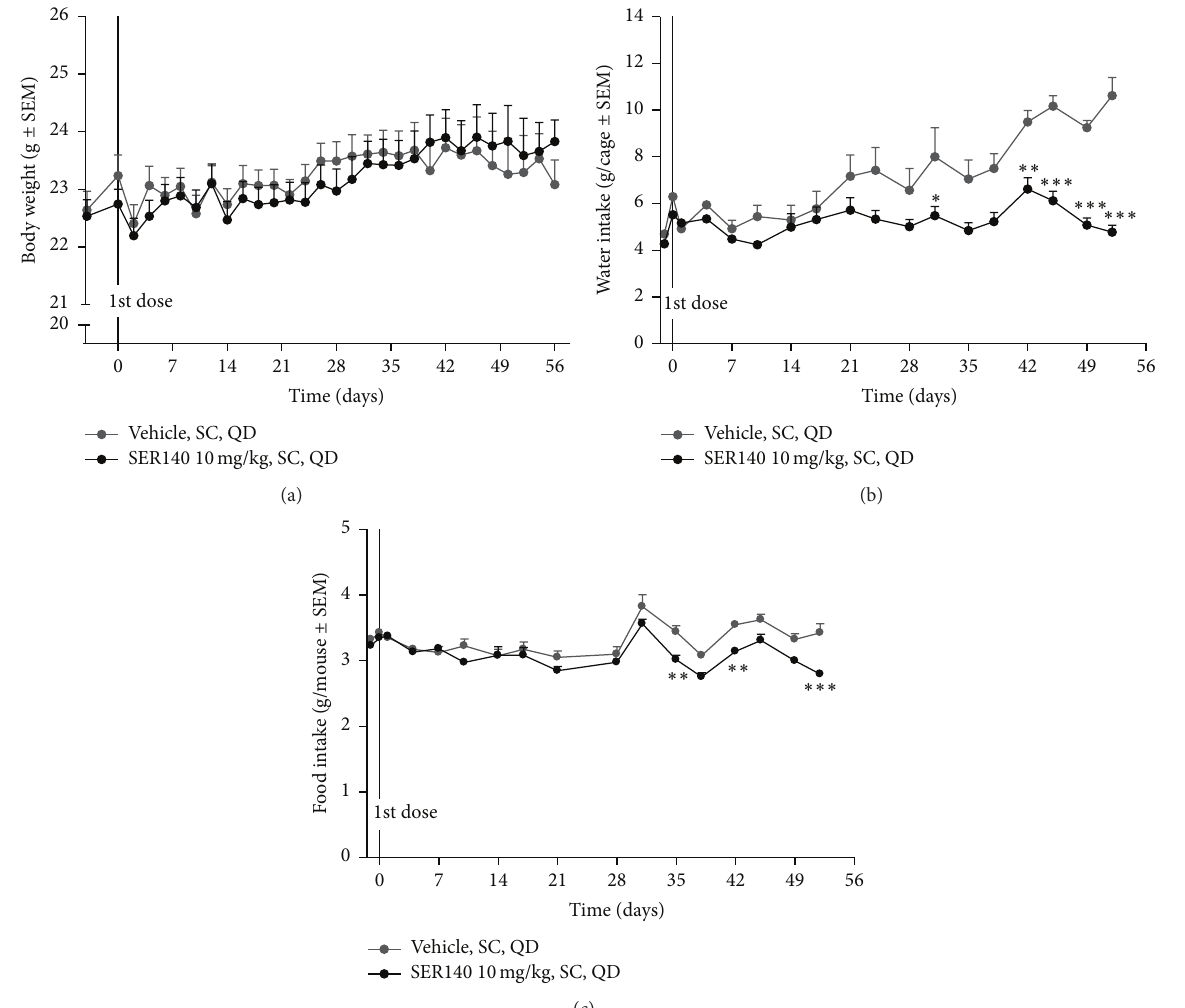
Figure 3: Daily body weight (a), water intake (b), and food intake (c) during the 56-day study period. All data are presented as mean ± SEM ( 𝑛 = 18 –20/group). ((a)–(c)) ∗ 𝑝 < 0.05 , ∗∗ 𝑝 < 0.01 , and ∗∗∗ 𝑝 < 0.001 compared to vehicle; two-way ANOVA w/Bonferroni post hoc test.